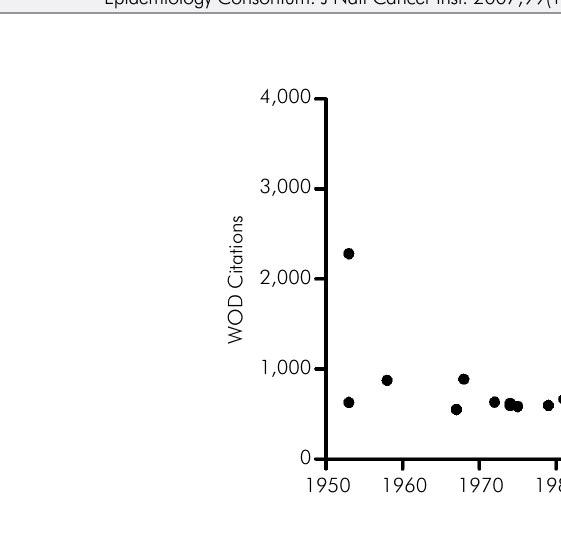
Figure 1. Number of citations per